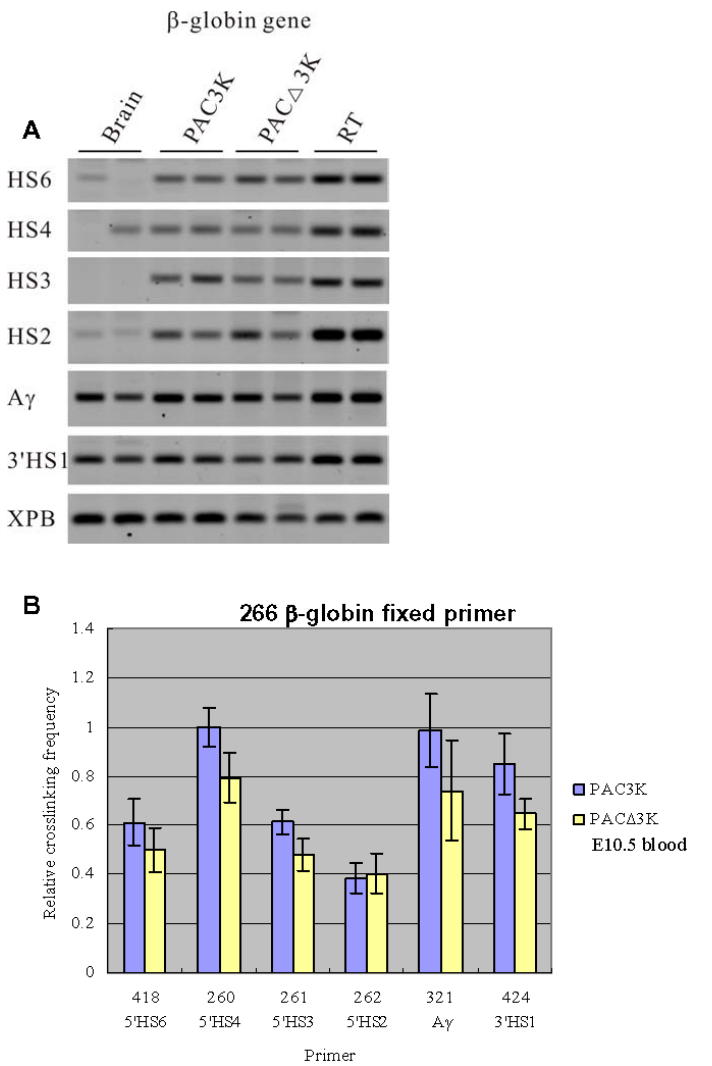
Figure 5. 3C analysis of the PAC3K and PAC D 3K transgenes using a primer from the human b -globin gene as the fixed primer. Embryonic blood was collected from E10.5 embryo for this set of 3C experiment. (A) Representative expamples of the PCR fragments resulting from the 3C experiments. RT: Random template control. (B) Histograms of the relative crosslinking efficiencies after quantitation and normalization.